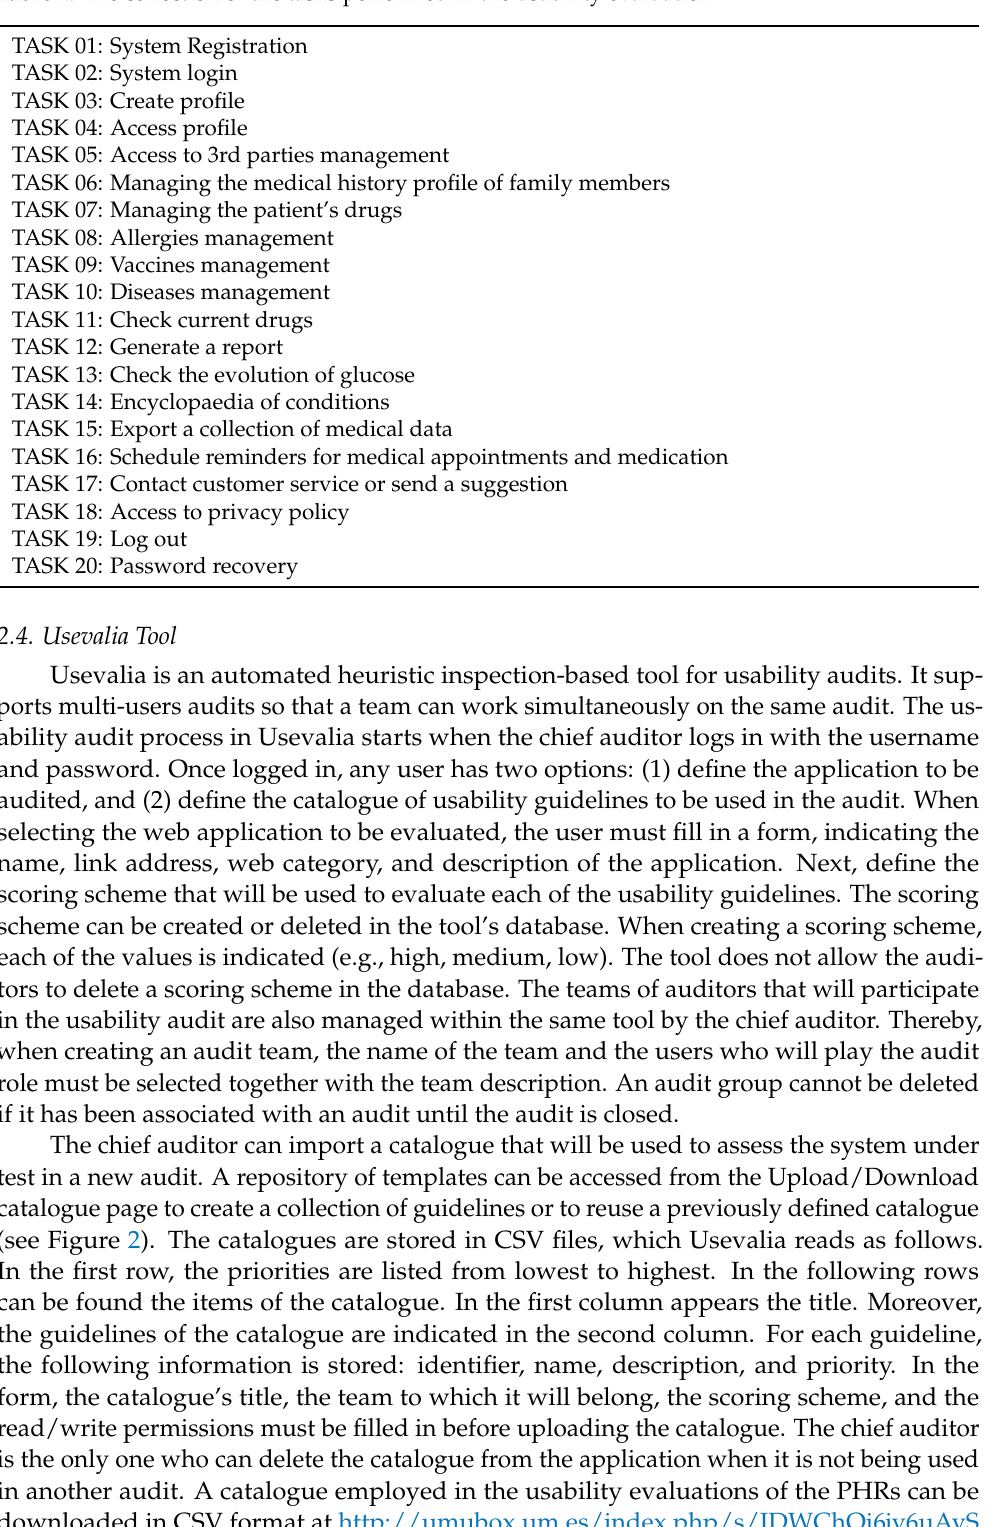
Table 2. The collection of the tasks performed in the usability